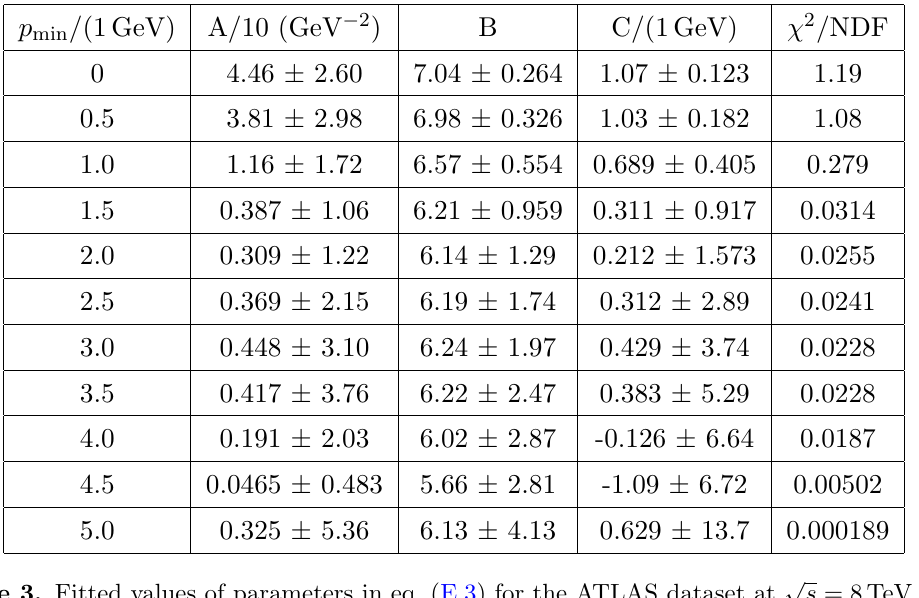
Table 3. Fitted values of parameters in eq. (E.3) for the ATLAS dataset at p s = 8 TeV [94].